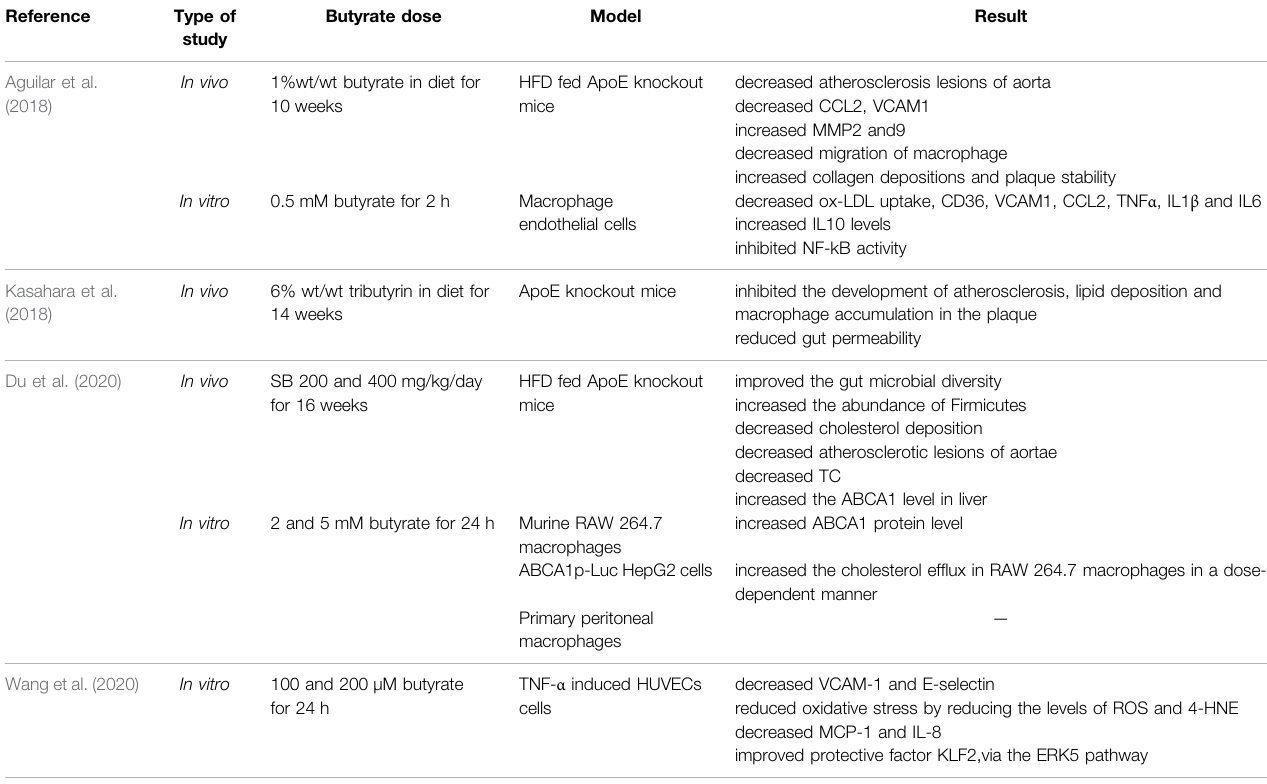
TABLE 1 | Summary of the studies about the effects of butyrate on atherosclerosis.